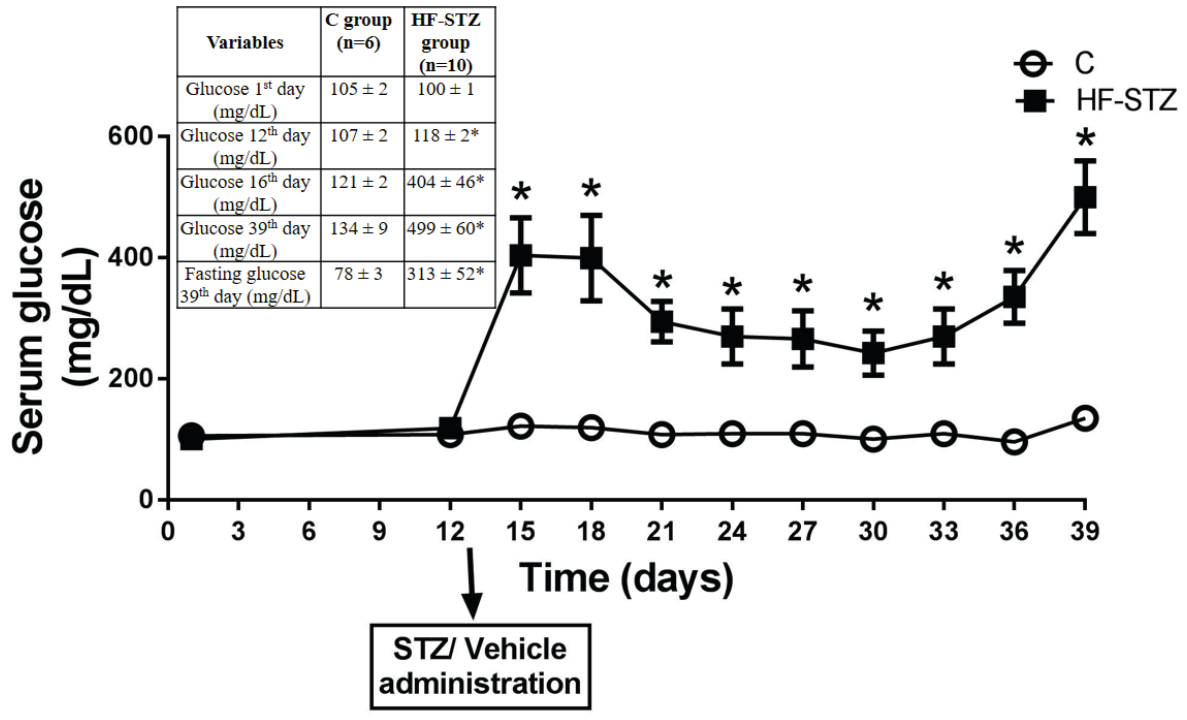
Figure 3 - Serum glucose (mg/dl) of fed male rats subjected to control diet (C) and high-fat diet/ streptozotocin (HF-STZ) for 39 days. Values in the table and figure are expressed as mean ± standard error across six control animals and ten HF-STZ animals in each analysis. Repeated-measures ANOVA for HF-STZ group (treatment P=0.0045, individual P<0.0001),*statistical difference versus C group, student’s t-test (P <0.05).